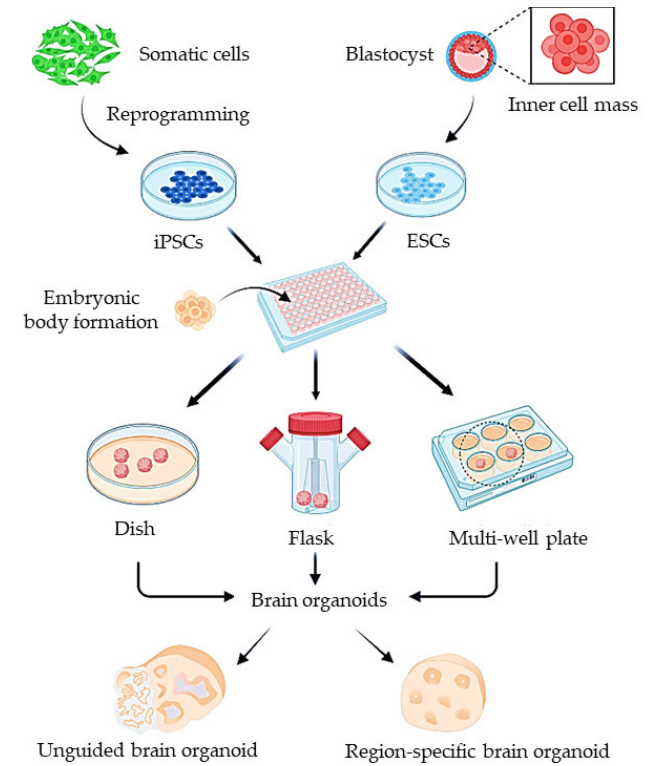
Figure 4. The generation of human organoids using induced pluripotent stem cells (iPSCs). Either iPSCs derived from somatic cells or embryonic stem cells (ESCs) are dissociated into single cells for generation of embryonic bodies (EBs). EBs are further cultured on dish, rotating flask, or multiple wells to form whole-brain organoids or region-specific organoids through guided differentiation. (Source: Reprinted from Lu, X.; Yang, J.; Xiang, Y. Modeling human neurodevelopmental diseases with brain organoids. Cell Regen. 2022 , 11 , 1–13, [165], under an open access Creative Commons CC BY 4.0 license).